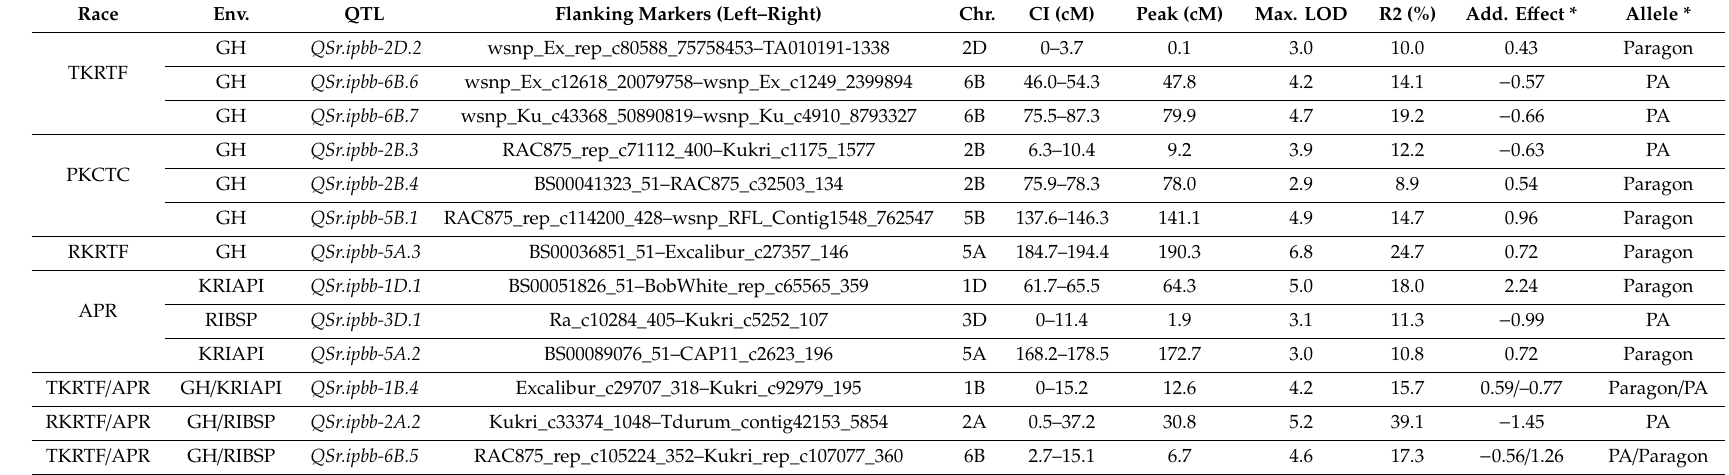
Table 8. The list of quantitative trait loci (QTLs) for APR and race-specific seedling resistance to stem rust (SR) identified in Pamyati Azieva × Paragon recombinant inbred lines (RILs)